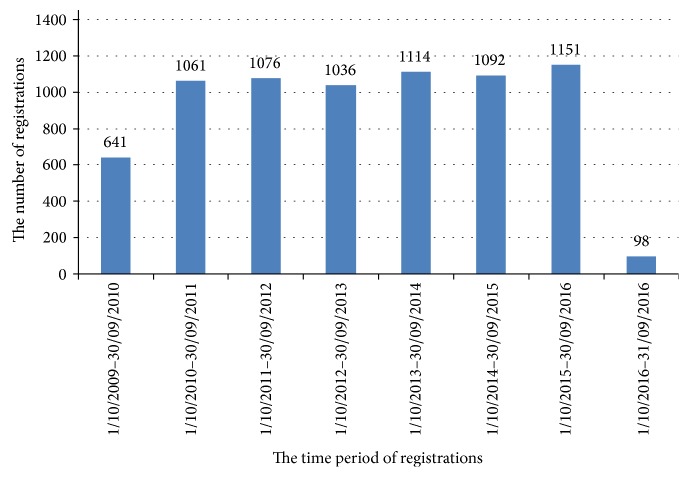
Overview of the number of registrations per year in the register over the 7-year period.